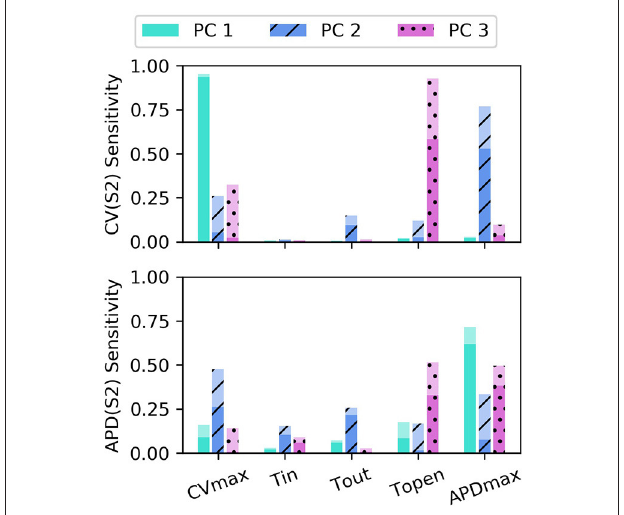
FIGURE 4 | Sensitivity indices of the coordinates f c of the principal components 8 c for the model parameters for S1: 600 ms. The total-effect indices are plotted semi-transparently, with the first-order indices (which contribute to the total-effect indices) overlaid with opaque shading.